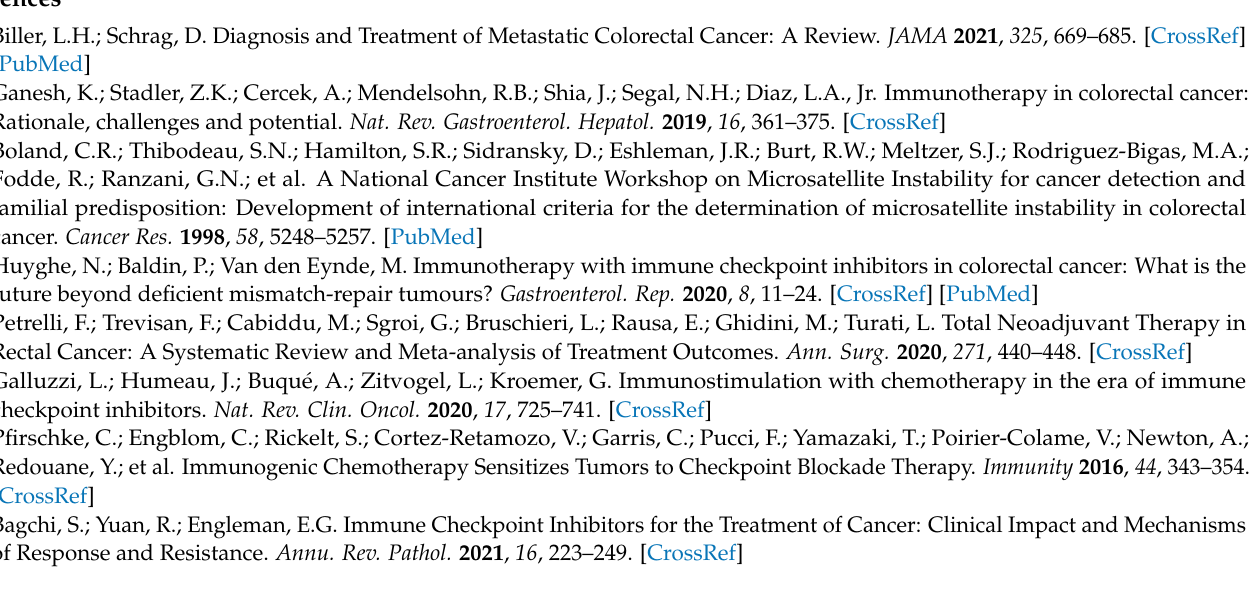
The assumption of Cox PH model